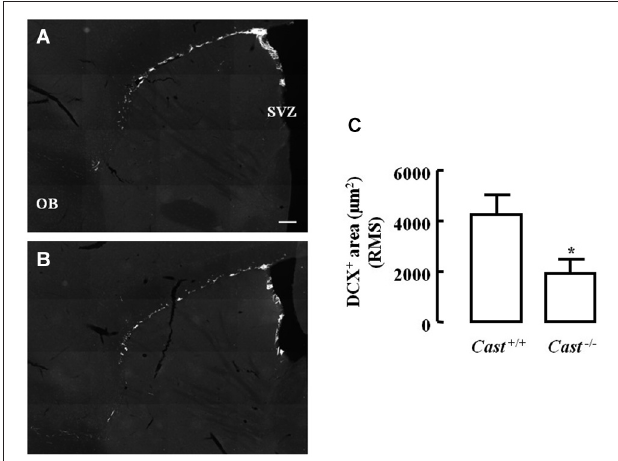
FIGURE 5 | Calpastatin deficiency decreases DCX immunoreactivity in the RMS . Representative images from sagittal striatal brain sections of Cast + / + (A) and Cast − / − (B) , showing migrating neuroblasts in gray, labeled for DCX. OB, olfactory bulb. DCX-positive area in the RMS (C) . Scale bar: 200 µ m. Means ± SEM of 5 independent experiments. Two-tailed t -test, * p < 0.05 (significantly different from Cast + / + ).